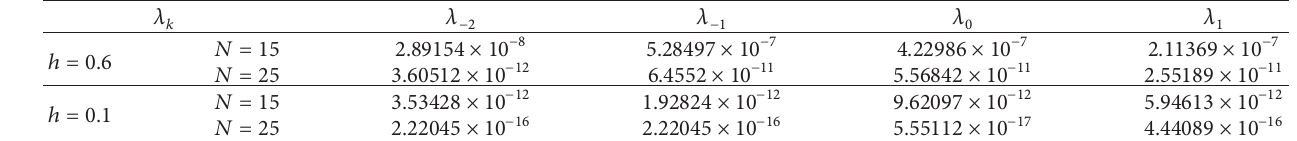
Table 2: Absolute error |𝜆 𝑘 − 𝜆 𝑘,𝑁 | .